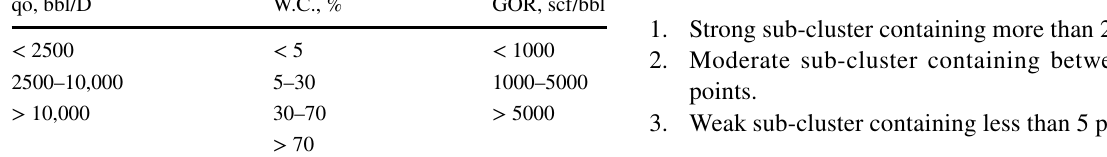
Fig. 3 Clusters map Table 3 Sub-clusters production criteria for oil wells [after Abd El- Moniem and El-Banbi (2015)] qo,